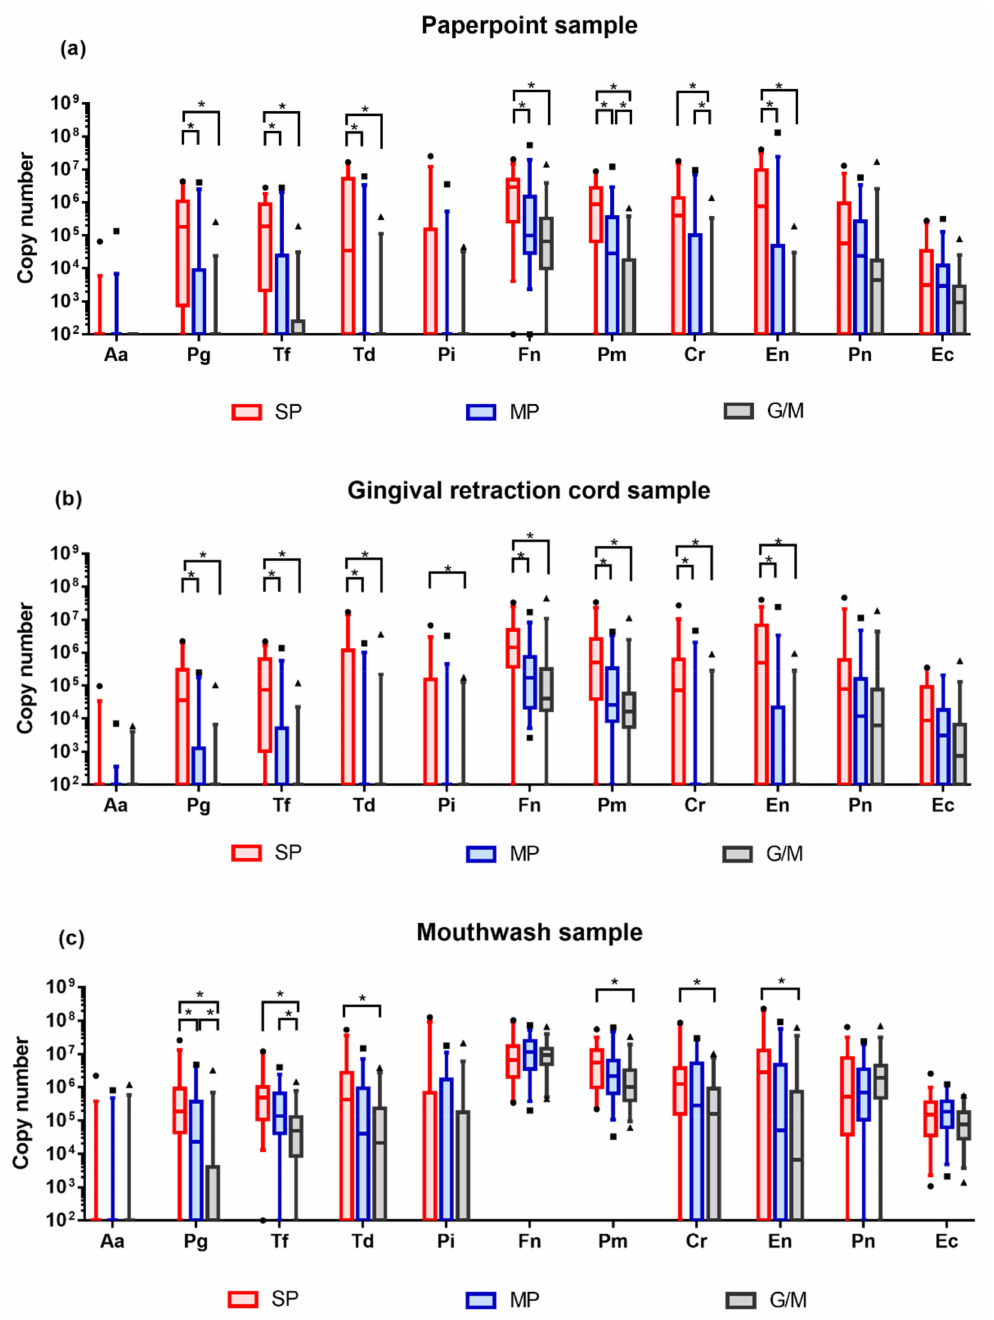
Figure 1. Quantitative profiles of target bacteria. DNA copy numbers are reported on a log 10 scale. DNA copy numbers are plotted with box and whisker plot, indicating interquartile range and 5–95 percentile, respectively. All comparisons were conducted with Kruskal–Wallis H test and Bonferroni